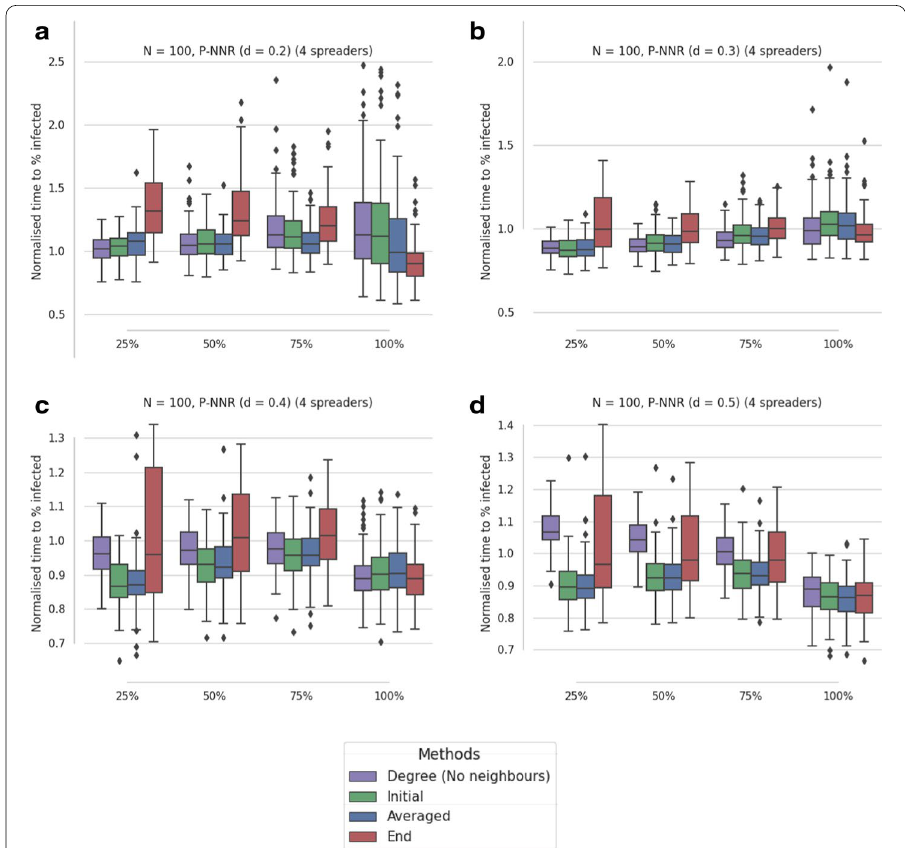
Fig. 4 Results from SI simulations ( τ = 1 ) of artificial contact networks using four selected spreaders. The median times from 100 artificially generated proximity networks are reported, where each median was assessed from 100 SI simulations. The proximity networks (P-NNR) are defined by the Euclidean distance threshold (d). In a d 0.2, a d 0.3, a d 0.4, and a d 0.5 where connection weights are given a value = = = = between 0 and 1 according to a uniform random distribution. Times are recorded when 25%, 50%, 75% and 100% of network are infected then normalised using division by the mean of all times recorded at each percentage. From left to right; times are detailed for the weighted degree (no neighbours) selection, then the optimised selections for initial rate ( Initial ), average performance ( Averaged ), and time to all infected ( End ). The y-axes of a , b are cropped to exclude extreme